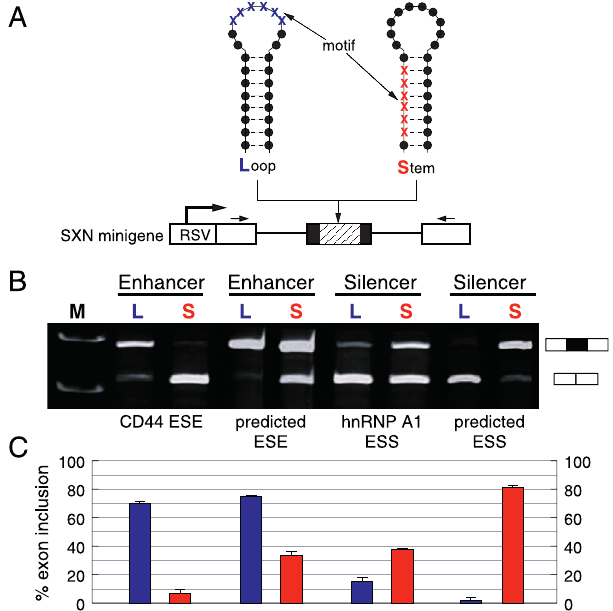
Figure 2. Influence of mRNA Conformation on Splice Site Selection (A) Experimental strategy. The structure of the SXN-derived minigenes is schematically indicated. White boxes represent constitutive globin exons, the black box represents the alternative exon where the motifs are introduced (shaded part). The motifs are either single-stranded in a loop (L) or double-stranded in a stem structure (S). Nucleotides that are part of the motif are indicated by blue (L) and red (S) crosses, flanking nucleotides by black dots. The thick arrow indicates the RSV promoter, small arrows the location of the PCR primers. (B) Analysis of the reporter constructs in vivo. L, motif is in a loop structure (single-stranded); S, motif is in a stem structure (double- stranded). A total of 1 l g of each construct was expressed in HEK293 cells and its RNA was analyzed after 24 h of transfection. An ethidium bromide stained agarose gel of representative experiments is shown. The structure of the products is schematically shown on the right. The sequences containing the motifs (underlined) and their PU values were: CD44 ESE: loop (ATCCATGGGGCTGGATGTGACGTACAACCACAATACGT- CACATACTTCCTCTCATGA, PU ¼ 0.998), stem (ATGATGGG- TATGTGCGTTGCTTCGGCAACCACAACTCATCGCATACTTCCTCTCATGA, PU , 0.001), predicted ESE: loop (ATCCATGGGGCTGGATGTGACGTAA- CAAGGCATACGTCACATAGCTTCCTCTCATGA, PU ¼ 0.994), stem (CTACCTTGCGCATGATACGCATGCGCAAGGTAGCACTGCATGAGCTTCCT- CACGTTT, PU ¼ 0.164), hnRNP A1 ESS: loop (ATCCATGGGGCTGGATGT- GACGTAGTAGGGTATACGTCACATAGCTTCCTCTCATGA, PU ¼ 0.976), stem (CTACCCTACGCATGATACGCATGCGTAGGGTAGCACTGCATGAGCTTCCT- CACGTTT, PU ¼ 0.126), predicted ESS: loop (ATCCATGGGGCTGGATGT- GACGTA GTAAGTGAATACGTCATATCTTACCTCTCATGA, PU ¼ 0.857), stem (ATCCAGTAAGCTACGCTCCGATGCGTAAGTGAGTCCGCTCACTTACG- CATCTCATGA, PU , 0.001). (C) Statistical analysis. The average percent exon inclusion of three independent transfection experiments for S and L constructs is: CD44 ESE, 70% versus 7%; predicted ESE, 75% versus 34%; hnRNP A1 ESS, 15% versus 37%; predicted ESS, 2% versus 81%. Error bars indicate the standard deviation from at least three independent experiments.